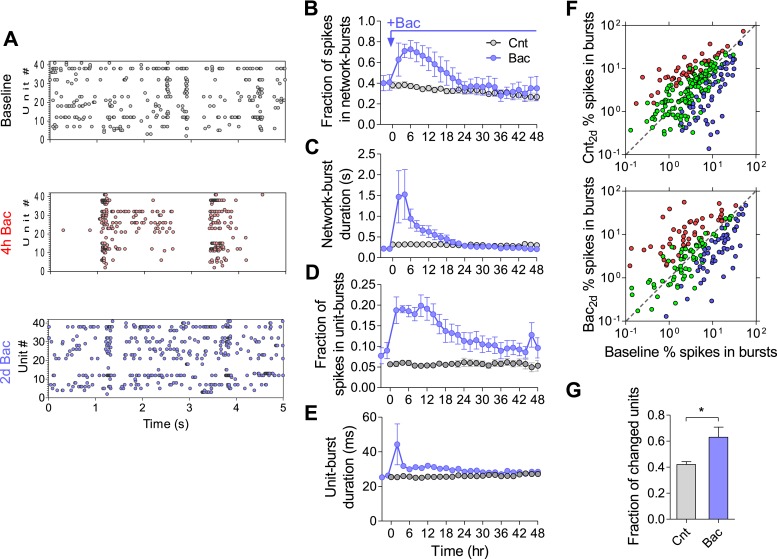
Temporal firing patterns are homeostatically regulated.(A) Representative raster plot of MEA recording before, 4 hr and 2 days after application of baclofen. (B) Baclofen causes a transient increase in fraction of spikes participating in network bursts (hours 2–4, p < 0.01; hours 4–10, p < 0.001; hour 12, p < 0.01; hour 14, p < 0.05; repeated-measures ANOVA with Bonferroni's multiple comparison test, compared to baseline values). The number of spikes that are part of network bursts was divided by the total number of spikes. (C) Baclofen causes a transient, short-lived, increase in duration of network bursts (hours 2–4, p < 0.001; hour 6, p < 0.05; repeated-measures ANOVA with Bonferroni's multiple comparison test, compared to baseline values). (D) Baclofen causes a transient increase in fraction of spikes participating in single-unit bursts (hours 2–4, p < 0.01; hours 4–12, p < 0.001; hour 14, p < 0.01; repeated-measures ANOVA with Bonferroni's multiple comparison test, compared to baseline values). The number of spikes that are part of single-unit bursts was divided by the total number of spikes of that unit. (E) Baclofen causes a transient, short-lived, increase in duration of single-unit bursts (hours 2, p < 0.001; repeated-measures ANOVA with Bonferroni's multiple comparison test, compared to baseline values). (F) Per unit correlation of fraction of spikes in single-unit bursts between baseline and 2 days after baclofen application: Top: control (n = 7; 279 units); Bottom: in the presence of baclofen (n = 5; 234 units). Colors represent units that significantly increased (red), decreased (blue), or remained stable (green) as determined by bootstrapping (see ‘Materials and methods’ for details). Note log scale of both axes. (G) Summary of data in (D) (*p < 0.05, unpaired, two-tailed Student's t-test). Error bars represent SEM.